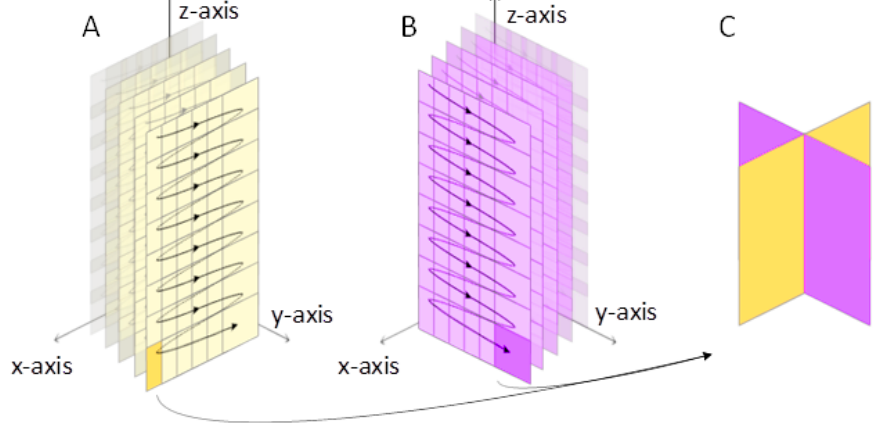
Figure 3. 3-D vector flow imaging (VFI) elaboration scheme. The beamformed volume samples are sequentially elaborated per plane in both directions (panels A and B ). The corresponding components are finally grouped to obtain the velocity estimation ( C ).